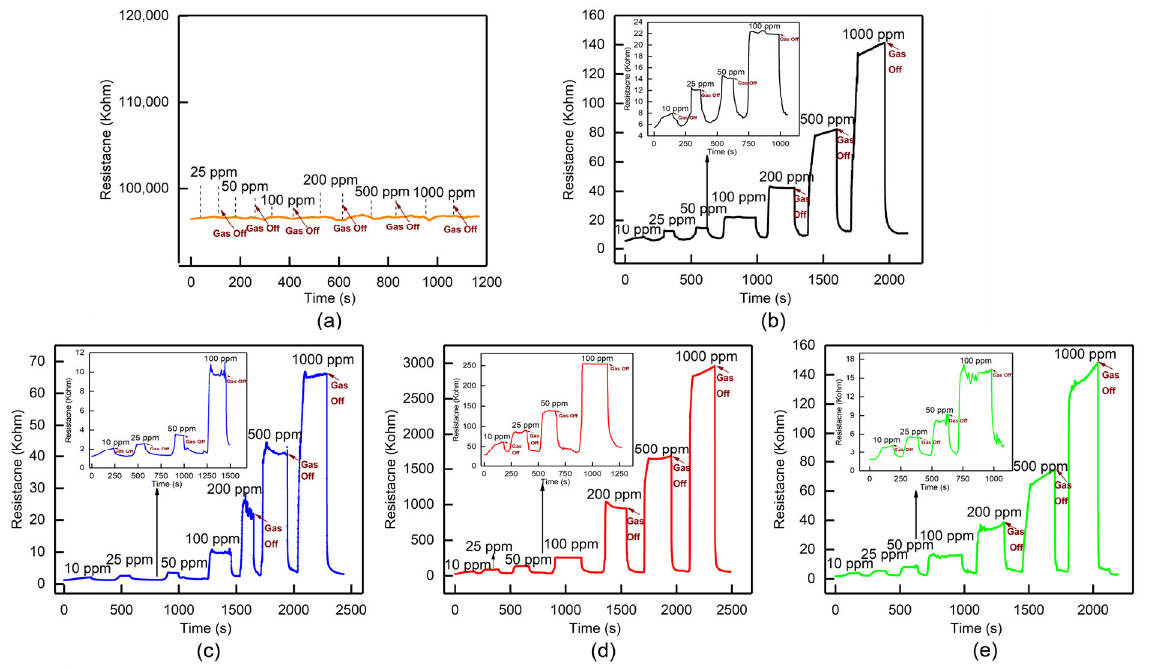
Figure 5. Transient resistance of gas sensors based on ( a ) pure MoTe 2 nanosheets, ( b ) pure PANI, ( c ) 2.7 wt.% MoTe 2 /PANI composites, ( d ) 8 wt.% MoTe 2 /PANI composites and ( e ) 16 wt.% MoTe 2 /PANI composites when exposed to various concentrations of NH 3 gas in a laboratory envi- ronment.